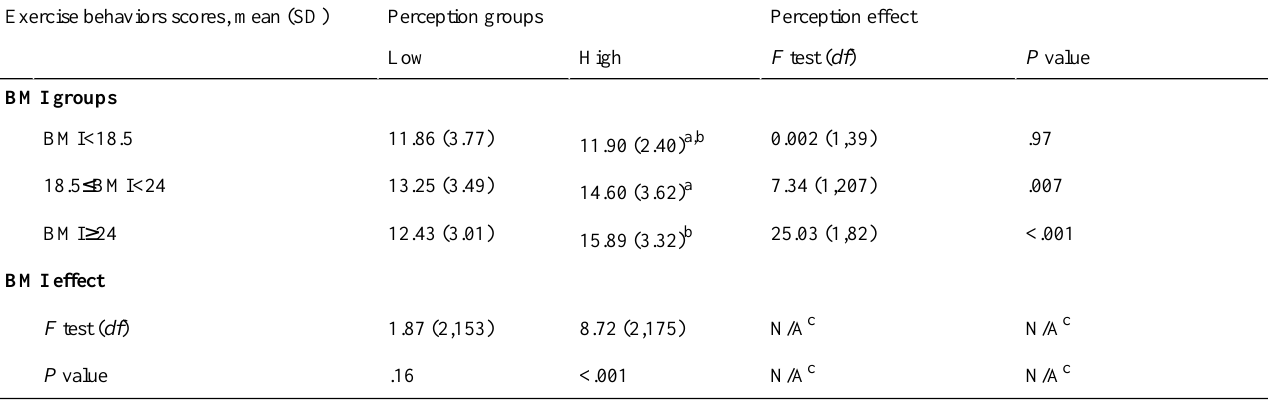
Table 4. Simple effects of the perceived importance of health and BMI on exercise